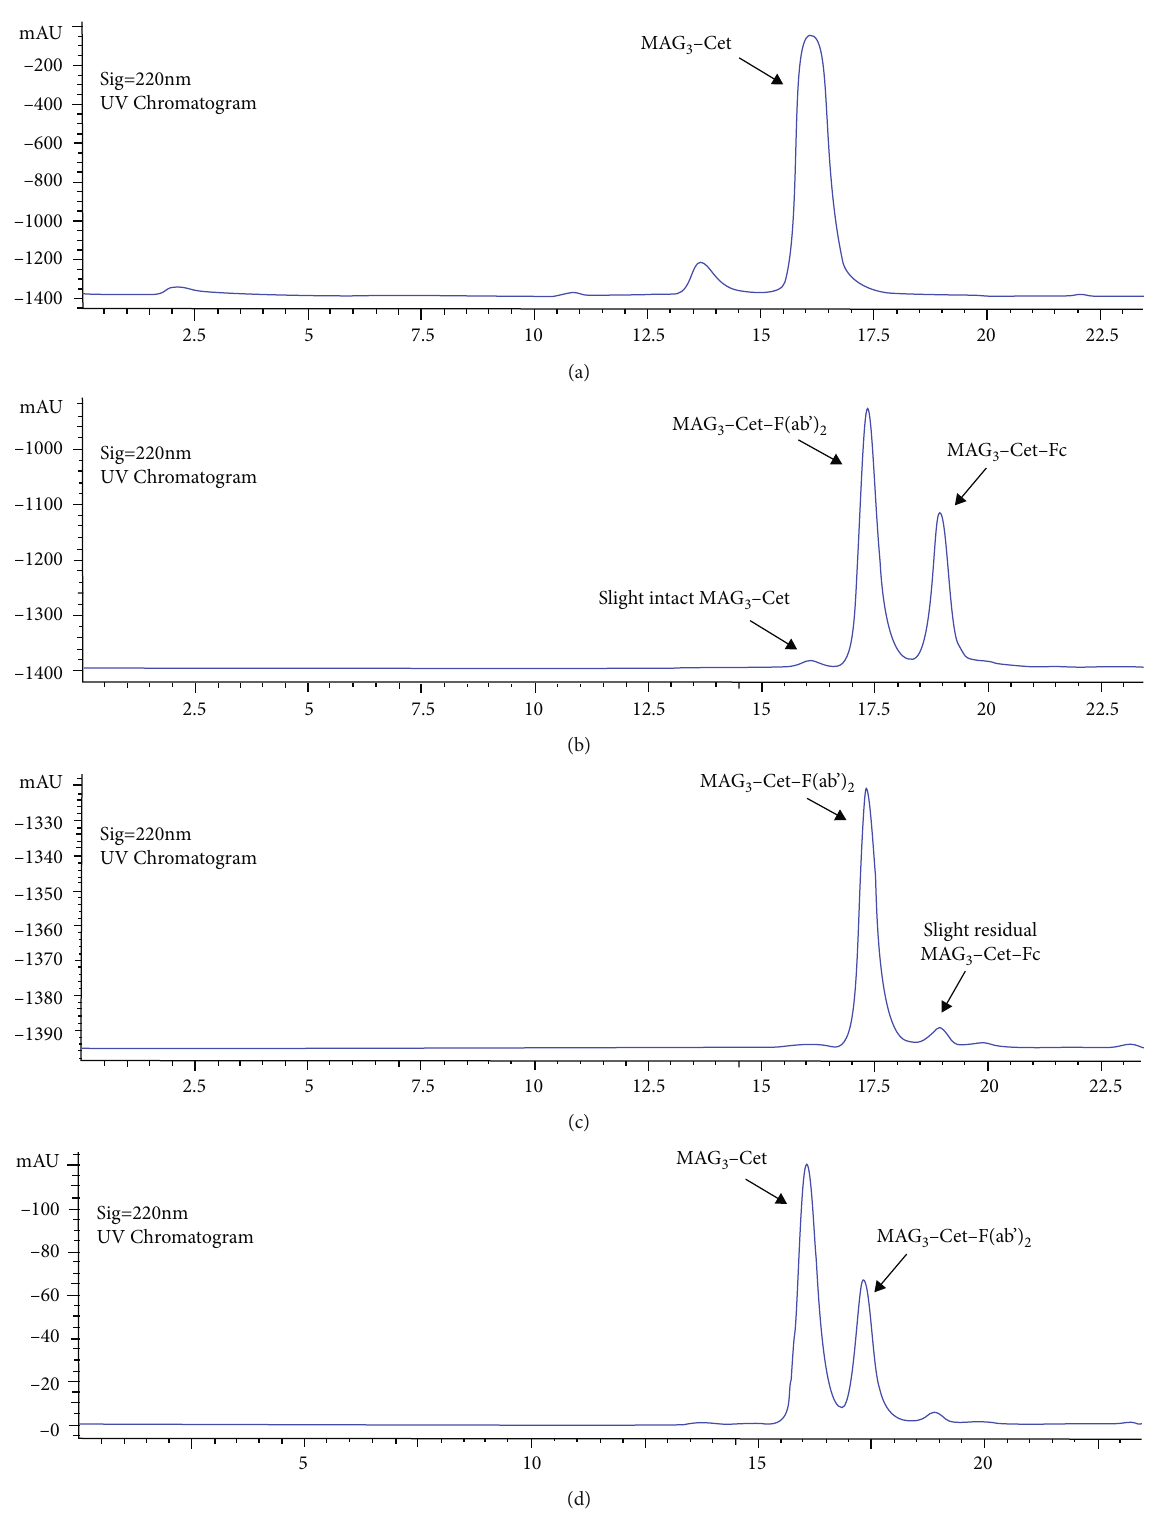
Figure 4: The HPLC results showing ultraviolet pro fi les of MAG MAG -Cet. (b) The HPLC result of MAG 3 result of the mixture from (b) but after reaction with protein A beads. The residual MAG removed by protein A beads. (d) The HPLC result of the mixture of (a) and